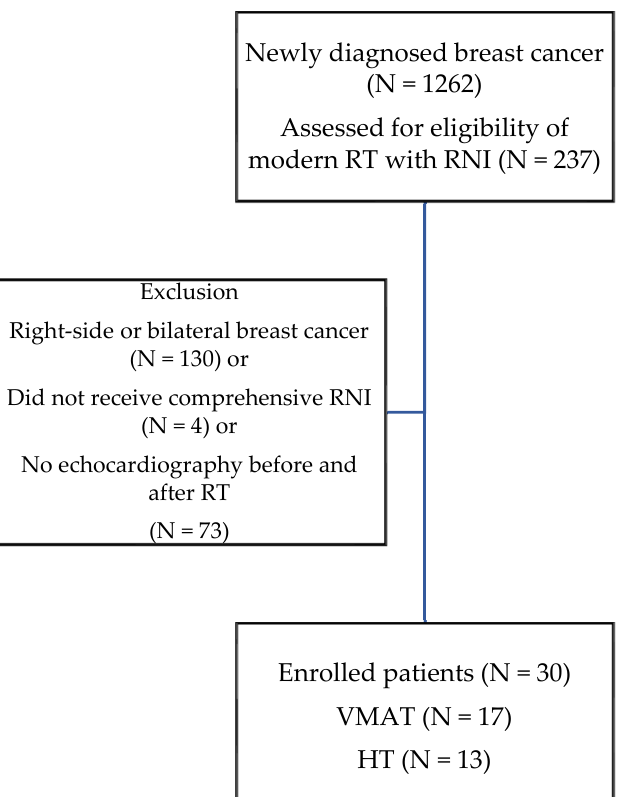
Figure 1. The process of patient enrollment. Abbreviations: RT—radiation therapy; RNI—regional